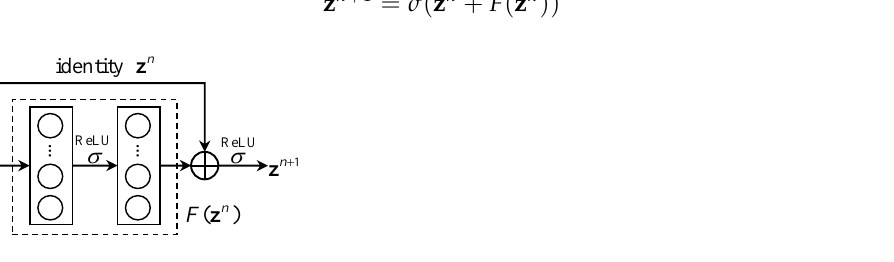
Figure 3. Block diagram of the residual block.